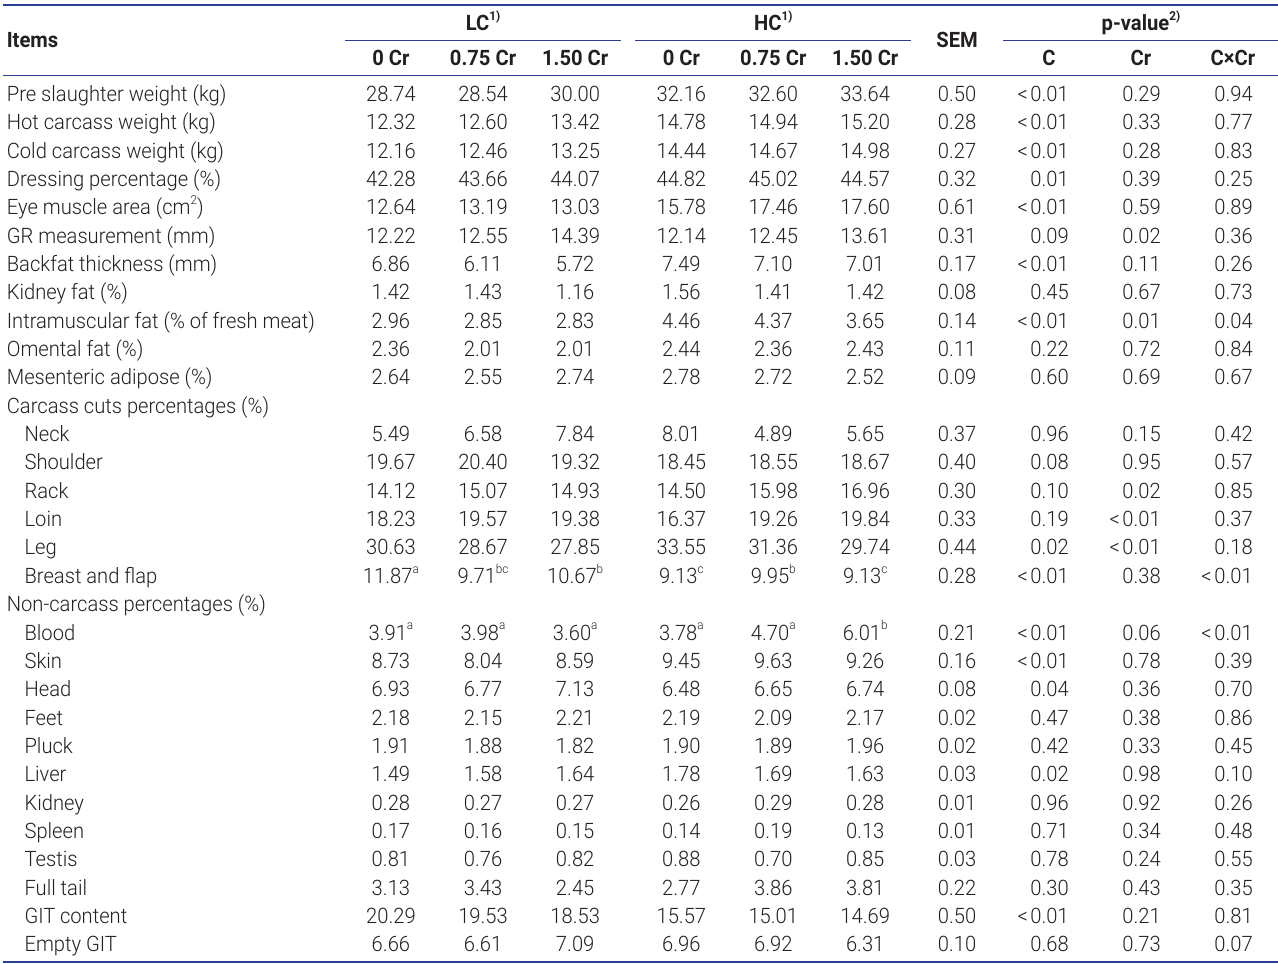
Table 6. Effects of concentrate level and Cr-Met supplementation on carcass characteristics of Tan